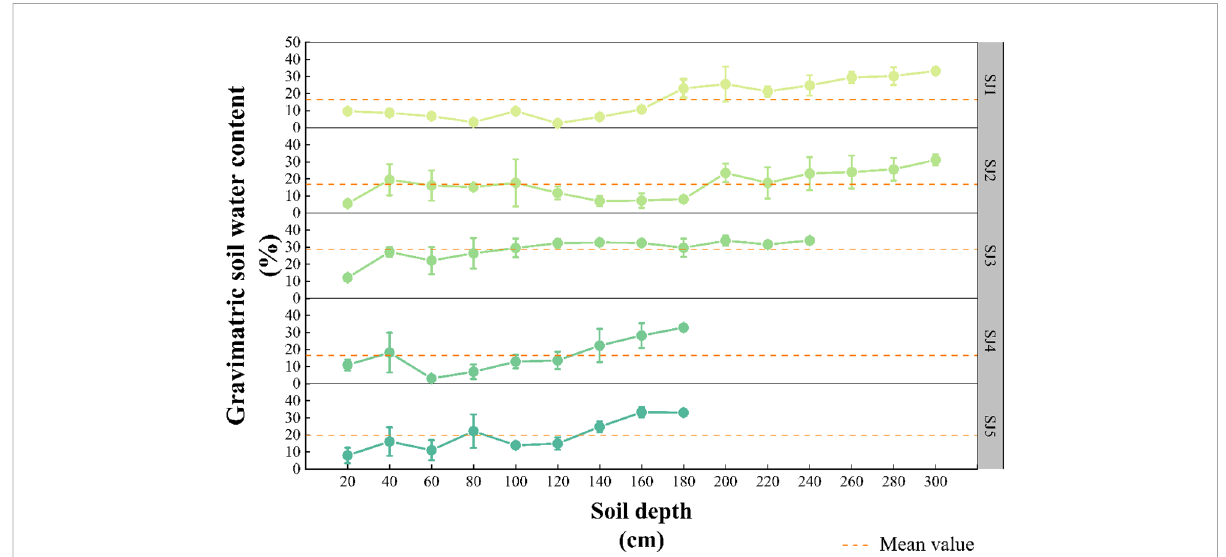
FIGURE 2 Vertical soil water content pro fi les of the different habitat conditions in the Daliyabuyi